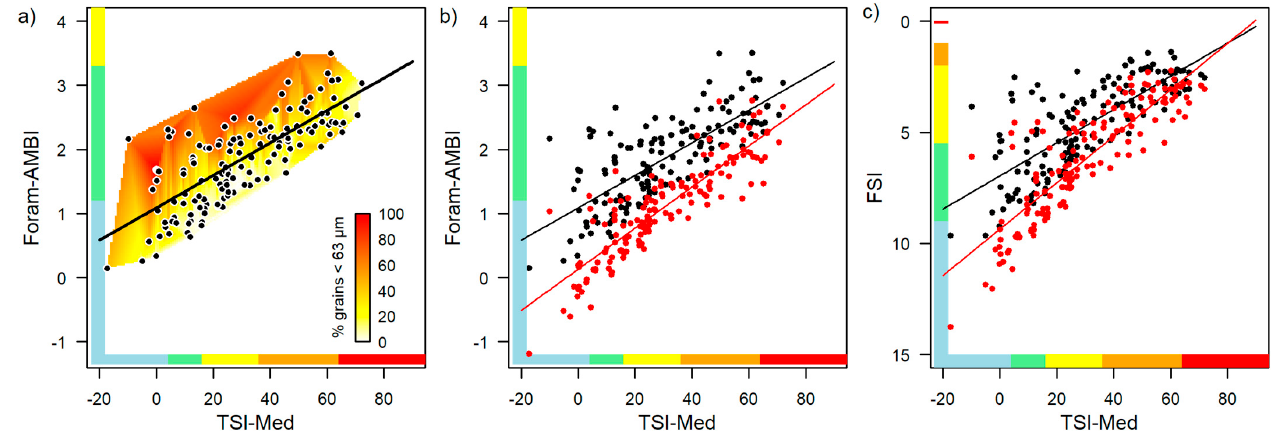
Figure 5. ( a ) Foram-AMBI as function of TSI-Med, (see Table 4 for regression line). ( b ) Foram-AMBI and TSI-Med. ( c ) FSI and TSI-Med. Black and red dots are the indices based on the homogenised list of indicator species (i.e. Foram-AMBI assign-ment [21]). In addition, red dots represent the grain size corrected Foram-AMBI and FSI as a function of TSI-Med. Black and red lines are the regression lines, see Table 4 for regression parameters. Coloured rectangles on the borders represent the EQS: blue, “very good”; green, “good”; yellow, “moderate”; orange, “poor” and red, “bad”. The scale for FSI is re-verse so that the environmental quality scale is in the same direction for each